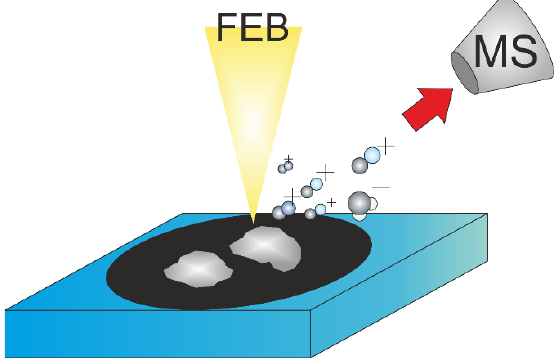
Figure 2. FEBiMS on solid compounds. The scheme shows non-volatile precursors’ grains fixed on carbon tape (black). The focused electron beam (FEB) fragments the compound molecules. Volatile ionized fragments are extracted to the mass spectrometer; neutral volatile fragments are pumped away. The 55° tilt of the sample and neutral fragments were omitted for clarity.